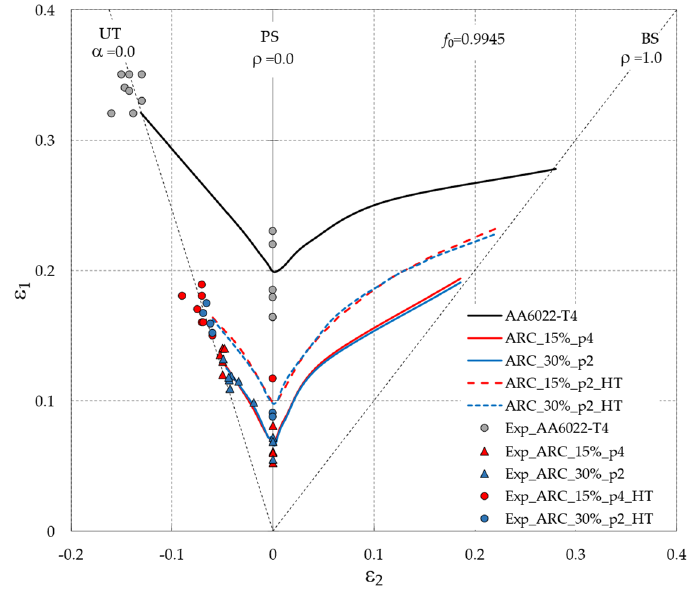
Figure 17. The effect of ARC conditions on the FLDs of AA6022 ‐ T4 sheets.